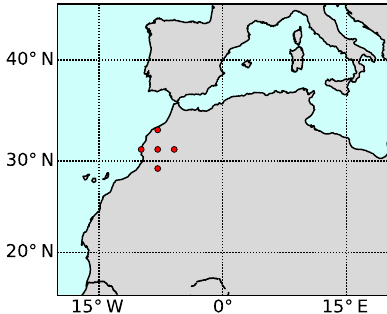
Figure 1. A map of the measurement locations for the Fabry–Pérot interferometer (FPI) in Oukaïmeden Observatory. Each dot repre- sents a possible 250km observation point of a single FPI measure-